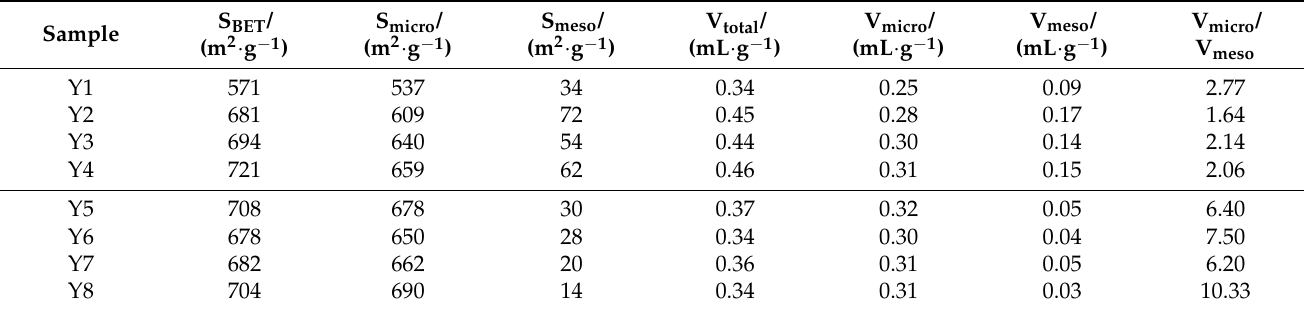
Table 4. Porosity of Y zeolites.